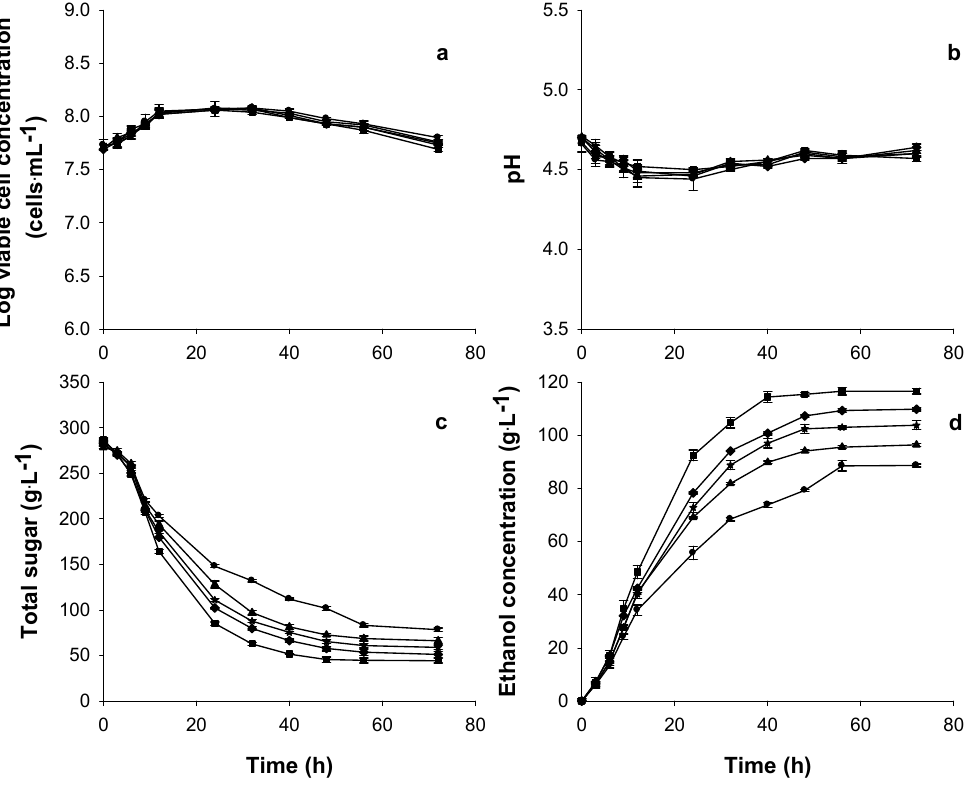
Figure 1. Fermentation parameters during single batch ethanol production from sweet sorghum juice with and without DSY (dried spent yeast) or yeast extract supplementation: no supplement ( ● ), 11 ( ▲ ), 16 (  ), 21 ( ♦ ) g·L − 1 of DSY and 9 g·L − 1 of yeast extract ( ■